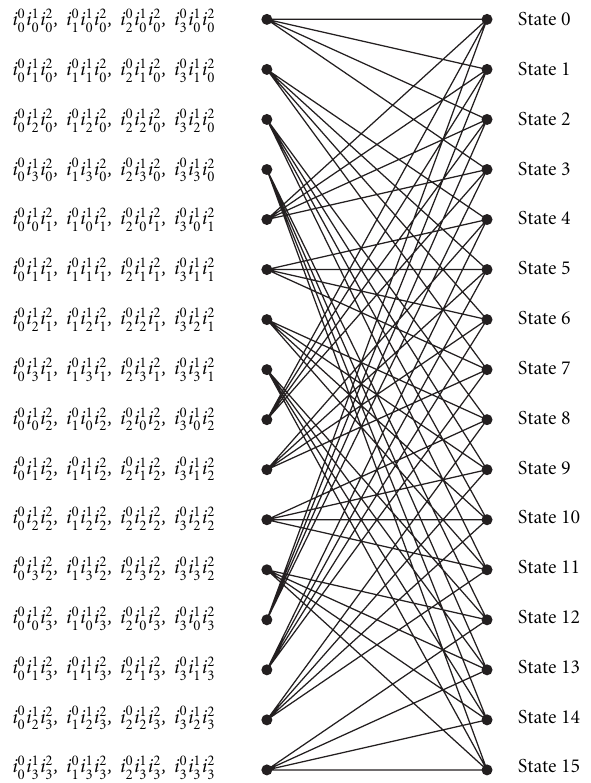
Figure 3: Example ST code template for three antennas, 4-ary con-